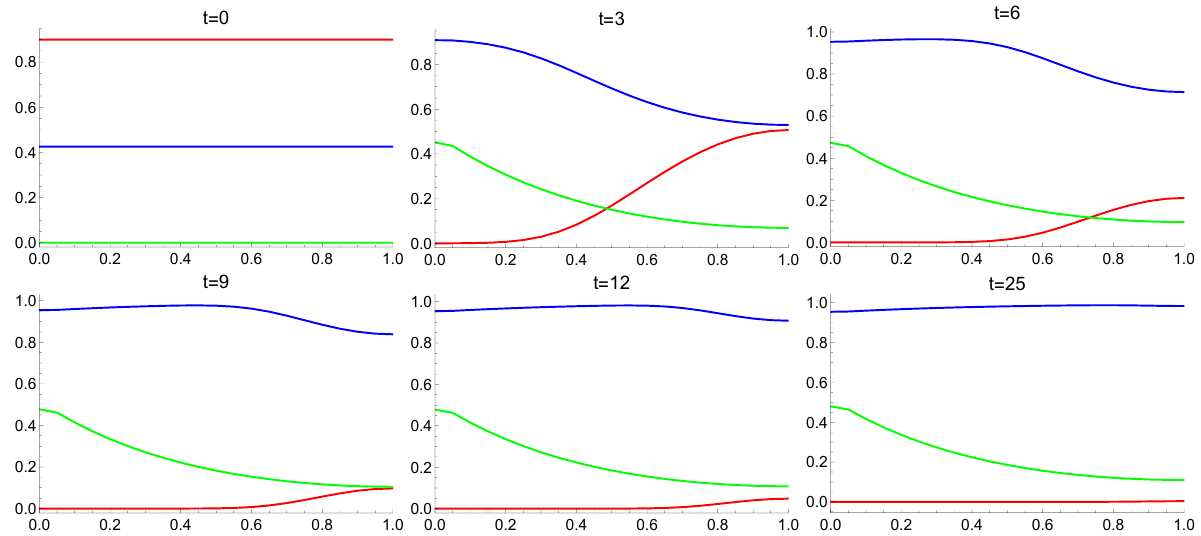
Fig. 4 Results of Simulation 4, with Ω = [ 0 , L ] = [ 0 , 1 ] . Plots of model solutions A ( x , t ) (cancer cells, red), N ( x , t ) (normal cells, blue) and D ( x , t ) (chemotherapeutic drug concentration, green) at time points t = 0 , 3 , 6 , 9 , 12 , 25. See Table 1 for parameter values used here. At time t = 0, the tumor is spread trough the tissue, and as chemotherapy is applied ( t > 0), the tumor cells are reduced and in the entire tissue. In comparison with Simulation 2, the tumor extinction is reached because the drug diffusion coefficient σ is increased here.